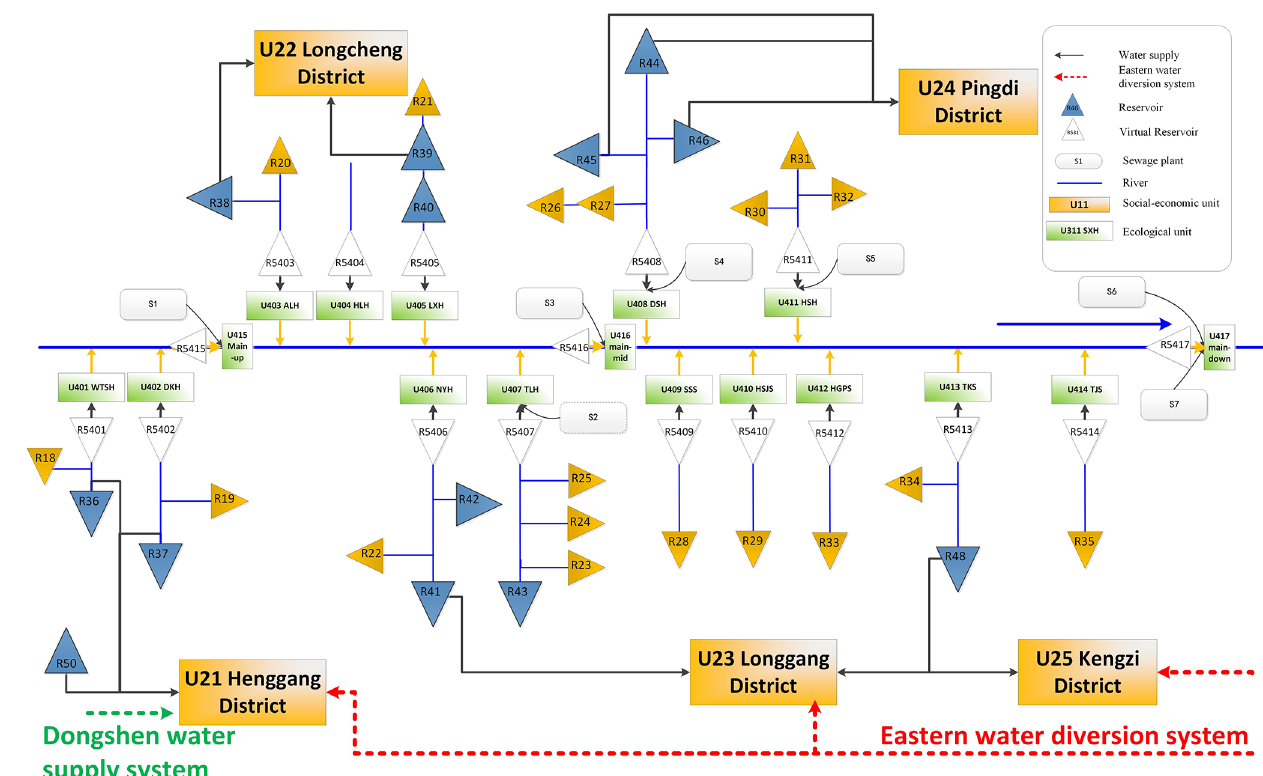
Figure 4. Water resource allocation network of the Longgang River